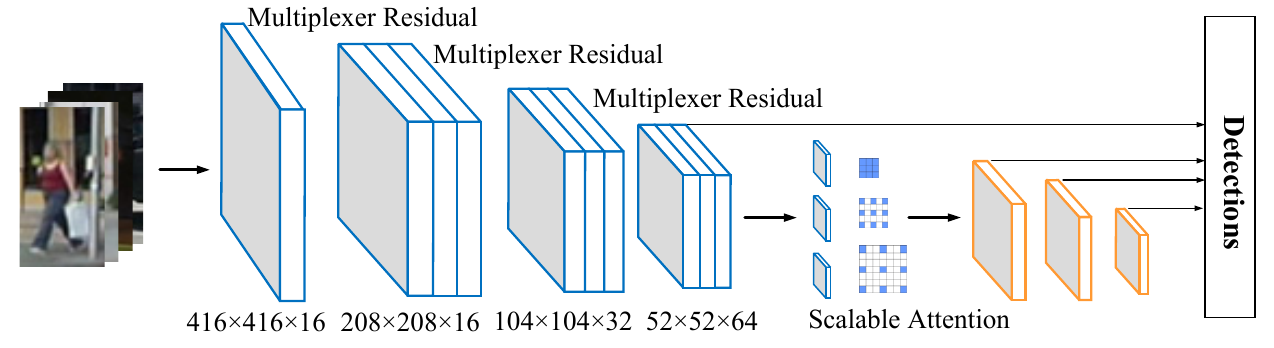
Figure 1. The network structure of FMRN.